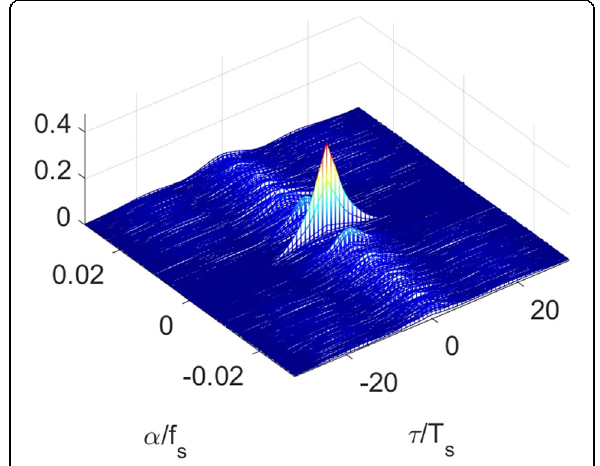
Fig. 6 Case B: magnitude of the cyclic correlogram of the time-warped data (thick red) and of the data before warping (thin blue), as functions